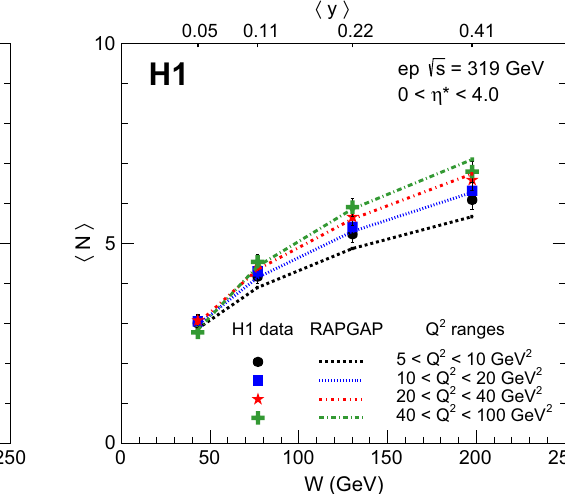
Fig. 8 Mean multiplicity (cid:8) N (cid:9) as a function of W measured at 319GeV ep collisions(left)andwithanadditionalrestrictiontothecur- rent hemisphere 0 < η ∗ < 4 (right). Further phase space restrictions